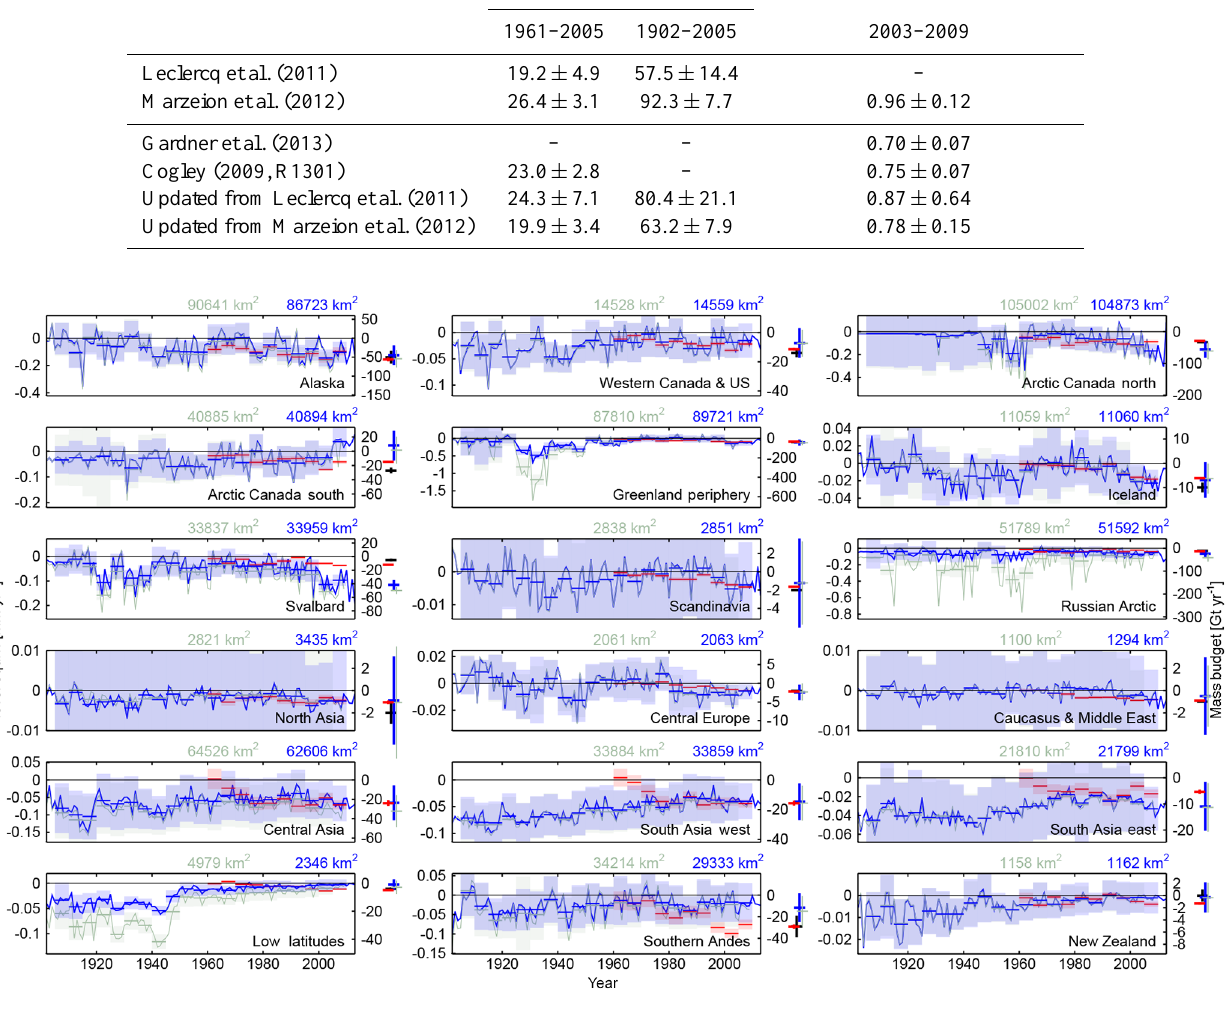
Figure 2. Regional glacier mass change rates; colors as in Fig. 1. Shading indicates the 90% confidence interval of the 5-year means. Numbers given at the top of each panel indicate glacier area in RGIv1.0 (green) and RGIv4.0 (blue). Crosses on the right of each panel give mass change rate and 90% confidence interval during